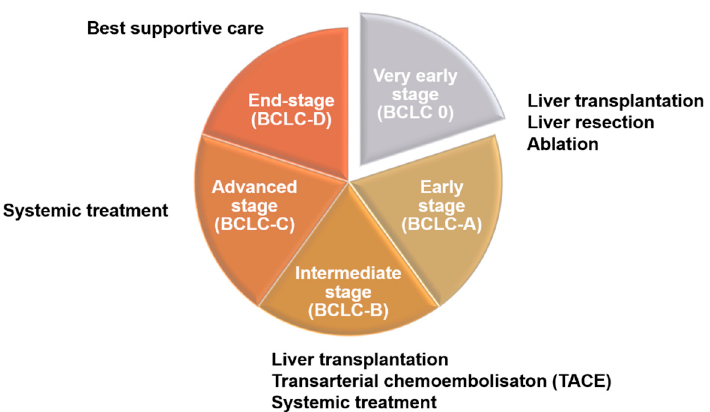
Figure 1. Treatment strategies for liver cancer at different stages. Patients in the early stage of liver cancer (0-A) are generally treated with surgery, such as liver resection, liver transplantation, and ablation. Intermediate-stage patients (B), after evaluation, will begin to receive systemic chemotherapy or transarterial chemoembolization (TACE). In the advanced stage, patients can be treated with second- line drugs that are different from first-line drugs after evaluation. At the end stage, if the treatment of patients has not significantly improved the survival rate, best supportive care should be used.